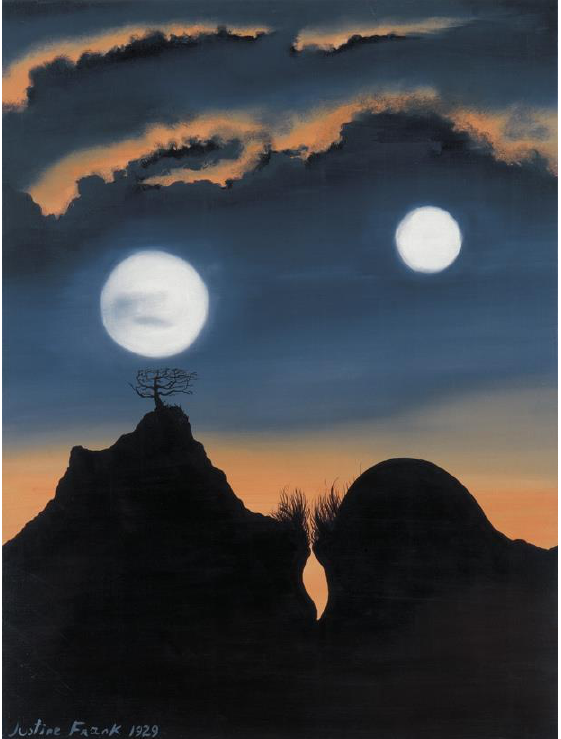
Figure 27. Justine Frank, Lunar Eye Disease , 1929, oil on canvas, 80 × 60 cm. Courtesy of the artist.